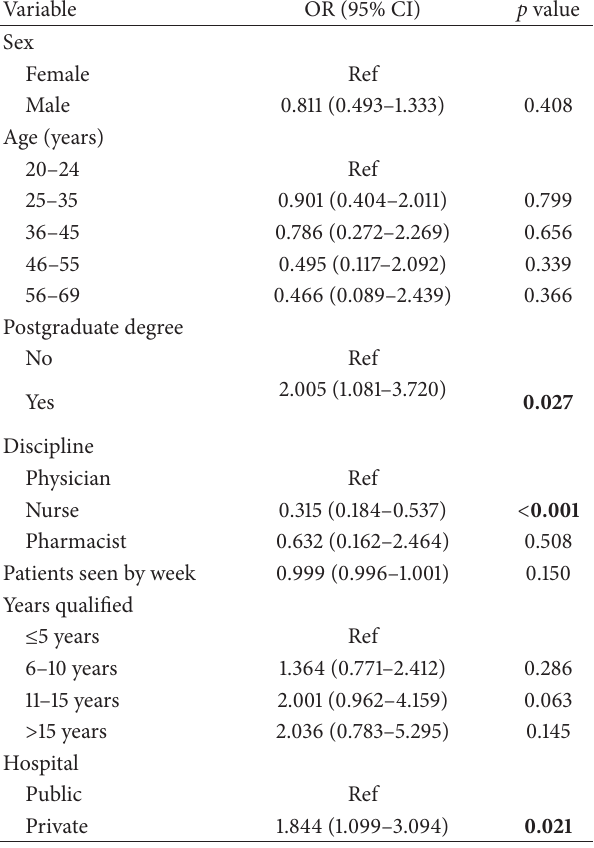
Table 3: Factors affecting respondents’ knowledge towards